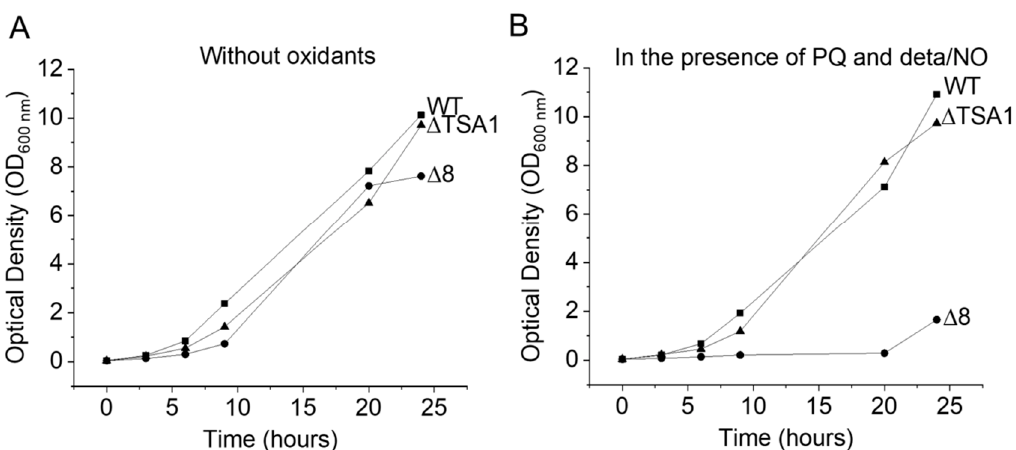
Figure 8. Growth curves of different S. cerevisiae strains under normal and stress conditions. ( A ) Growth of WT, Δ 8, and Δ TSA1 strains in YPD. ( B ) Growth of WT, Δ 8, and Δ TSA1 strains in YPD in the presence of PQ/NO • donor.